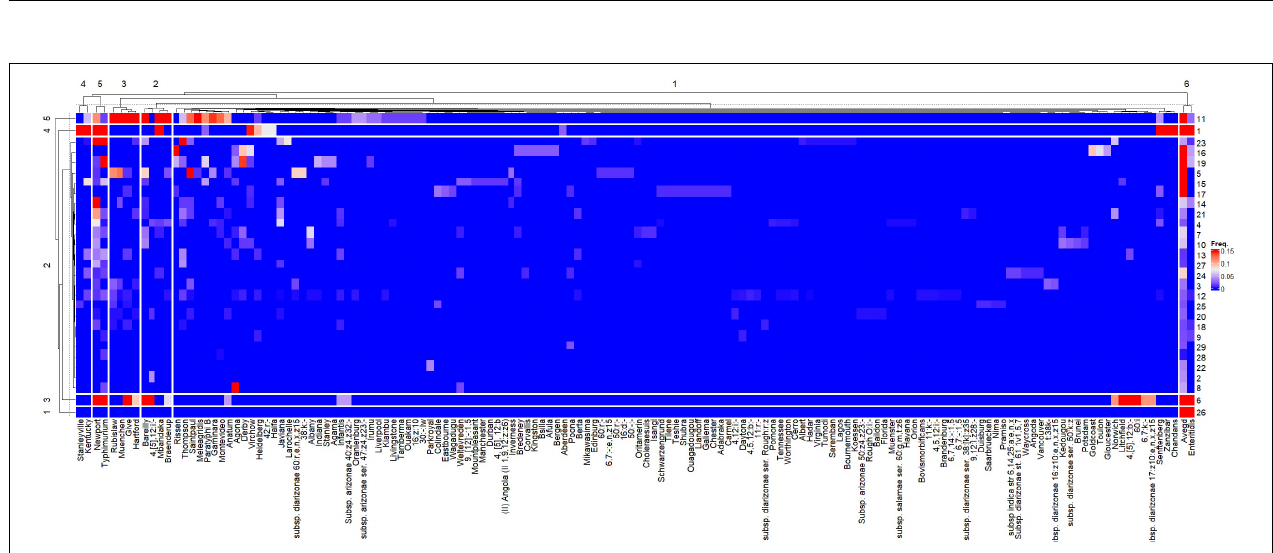
FIGURE 5 | Heatmap of the relative frequencies of Salmonella enterica serovars isolated from surface and groundwater sources as per reported in 26 peer-reviewed scientific publications between the years 2015 and 2020. The heatmap was built in R (package ComplexHeatmap).